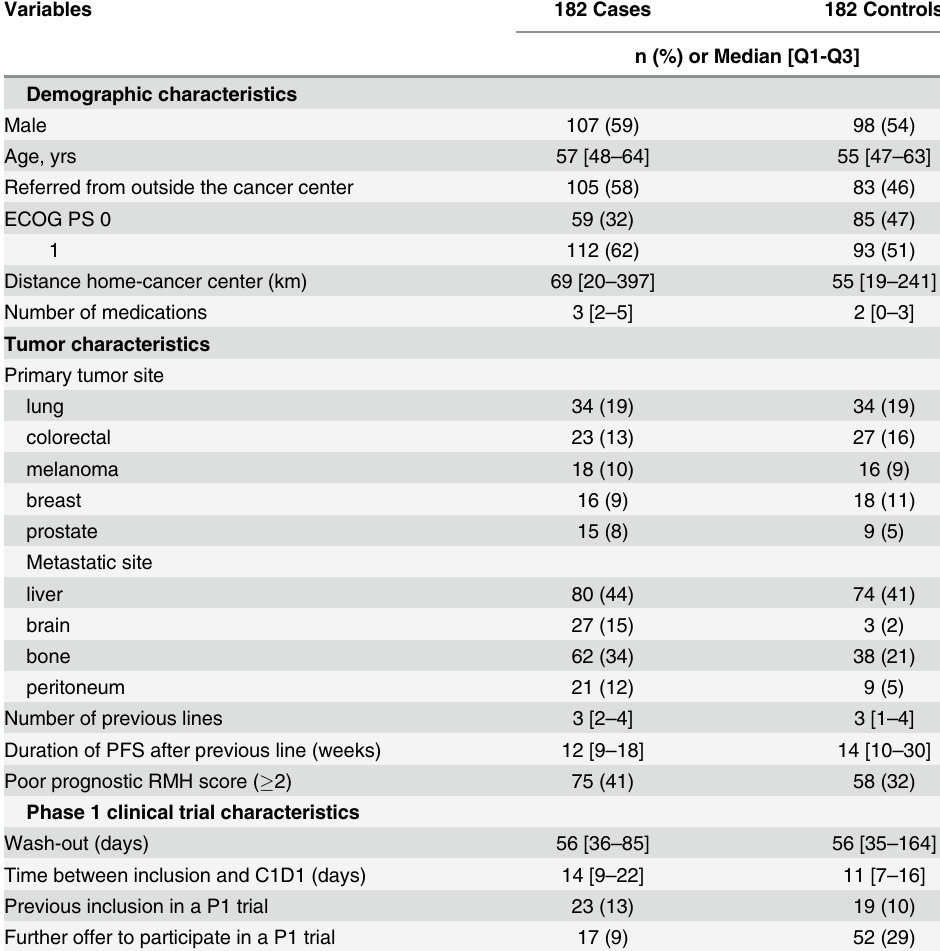
Table 1. Patient characteristics at the time of signing the informed consent form